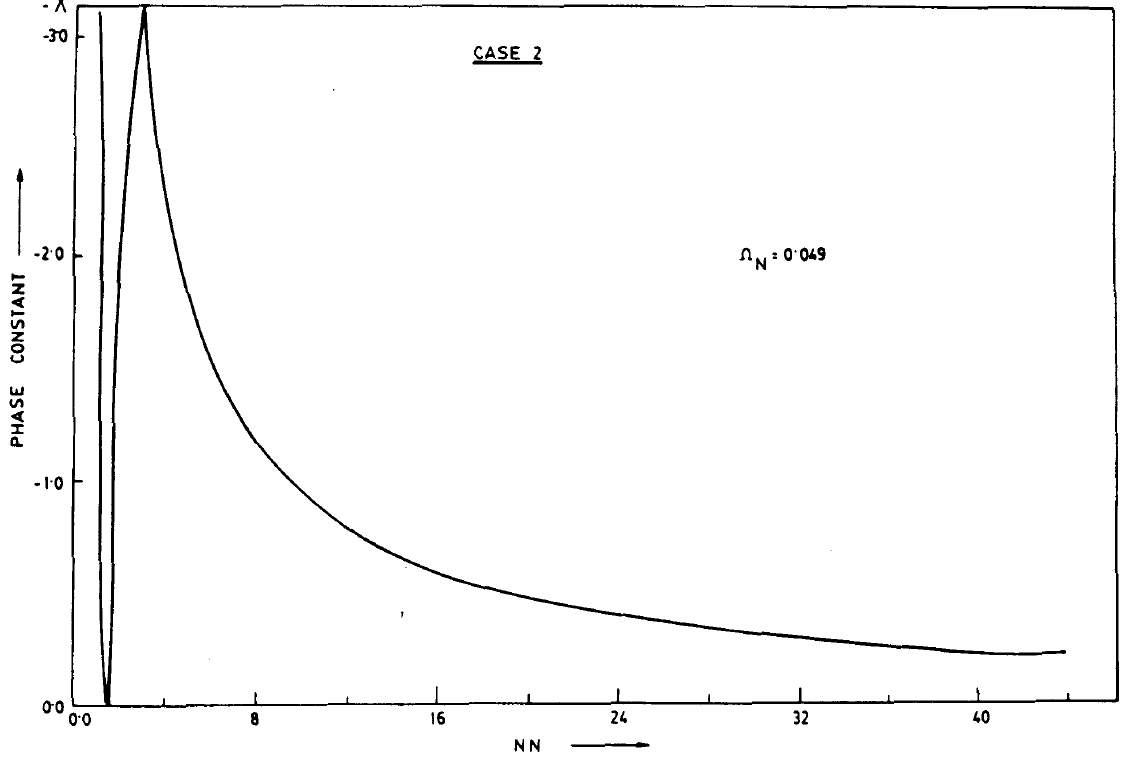
Fig. 6. Values of phase constant for different nodal patterns at the lowest bounding frequency (Case 2). between Ω N = 0 . 251 to Ω N = 0 . 955 is not